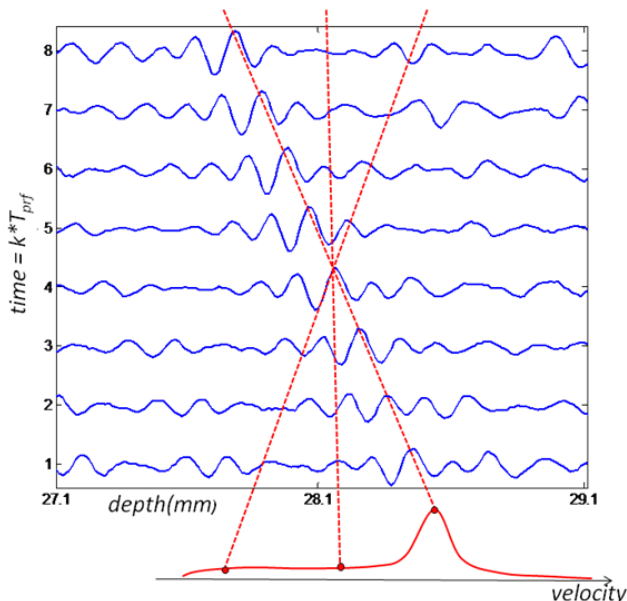
Figure 1. Example of 8 ultrasound emissions. Velocity spectrum is obtained by calculating 1D FFT along skewed lines in depth/time